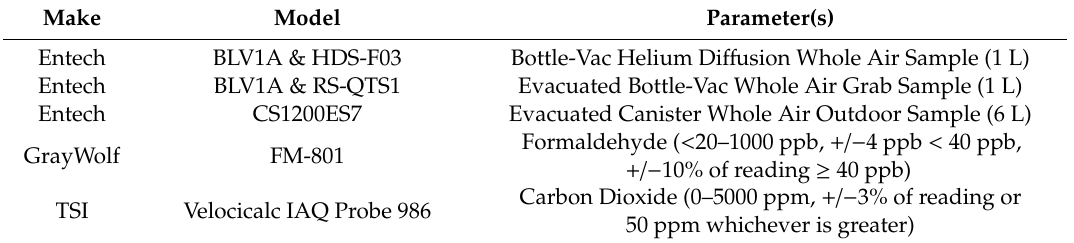
Table 1. Air quality monitoring and sampling instrumentation used in reported